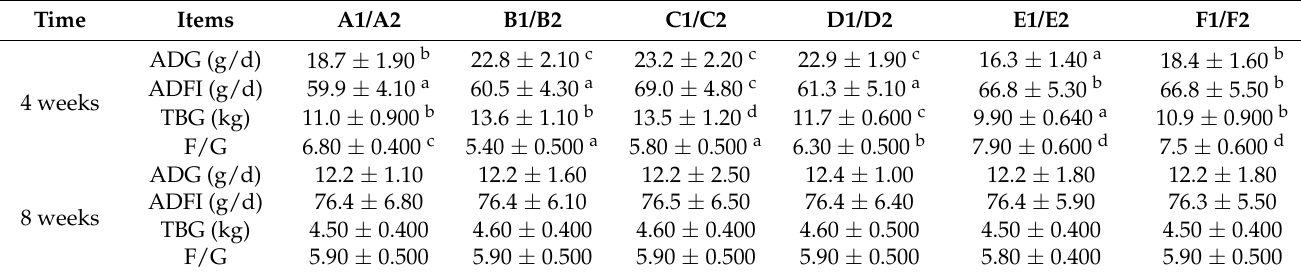
Table 2. Effects of Moringa oleoresin substitute for different ratios of rapeseed cake on the growth performance of broiler